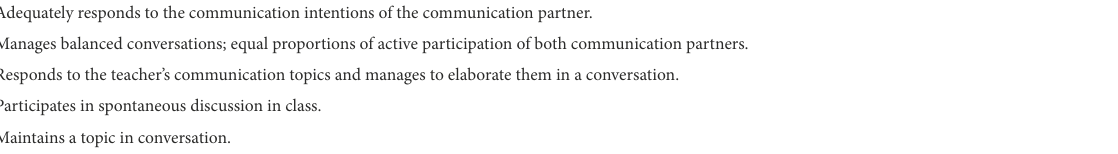
TABLE 1 Brief teacher checklist on conversation skills.